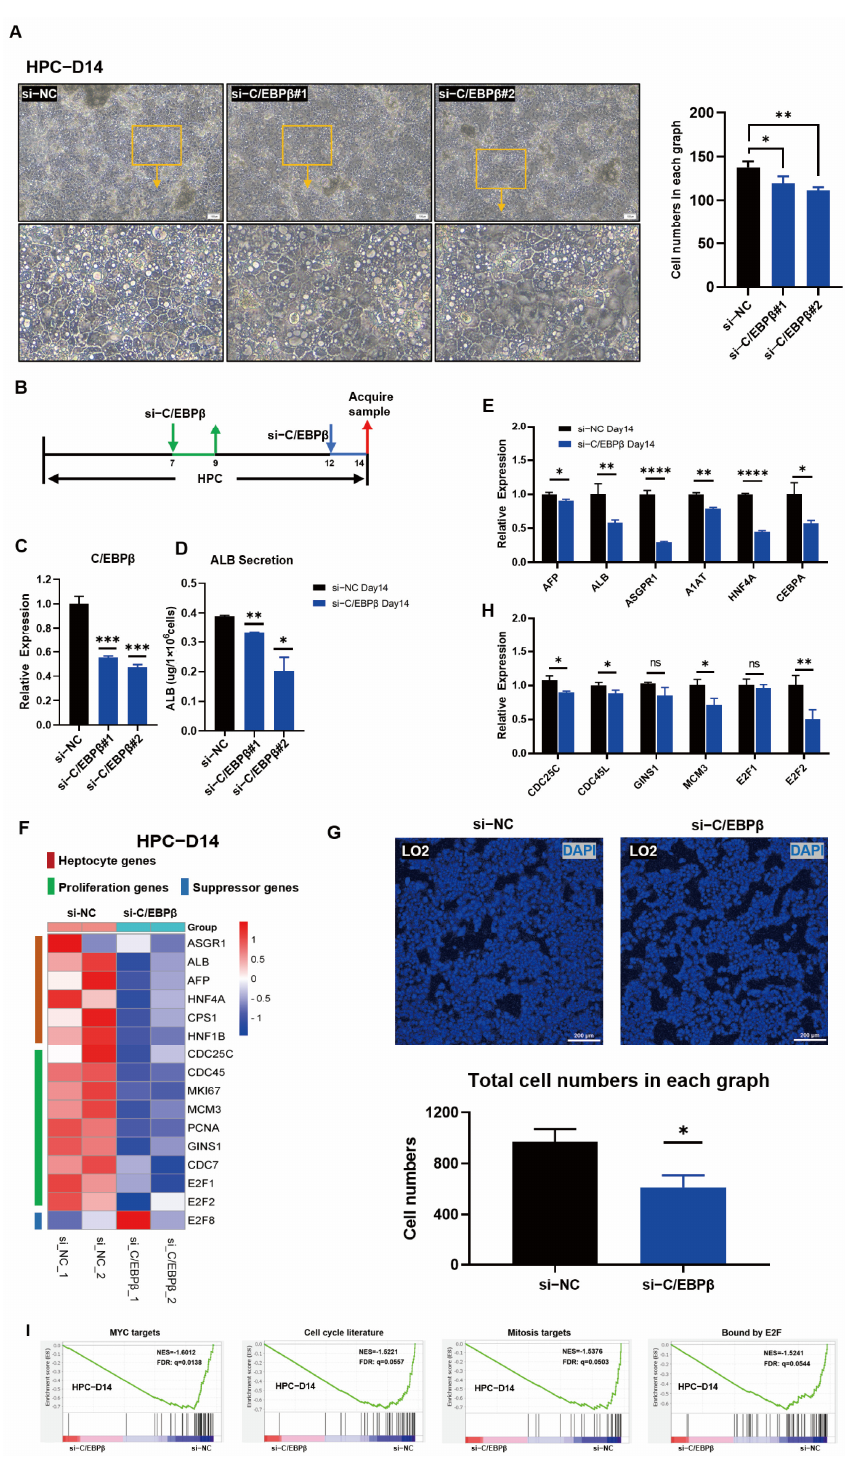
Figure 4. C/EBP β Knockdown impaired hepatic differentiation and blocked proliferation of HPCs. ( A ) Representative images of cell morphologies of HPCs 2 days after si-RNA treatments on day 12 and cell numbers were counted in each group in ( A ). ( B ) Schematic illustration of si-RNA mediated C/EBP β knockdown during the hepatic differentiation of hESCs. ( C ) Knockdown efficiency of C/EBP β was detected by qRT-PCR on day 14 of HPCs. ( D ) ALB secretion was detected from the supernatants of cultured HPCs 24 h after siRNA (C/EBP β ) treatment. ( E ) Relative gene expression analysis of hepatocyte genes including AFP, ALB, ASGPR1, A1AT, HNF4A, and CEBP α in HPCs treated with si-NC or with si-C/EBP β on day 14. ( F ) Heat map of selected genes, including